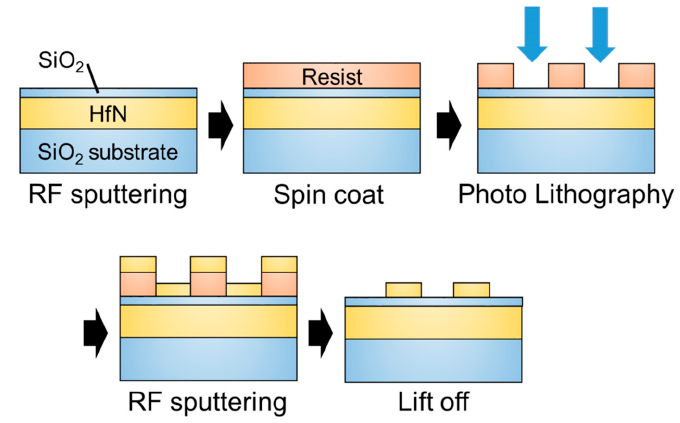
Figure A4. Fabricating the refractory MDM metasurface.